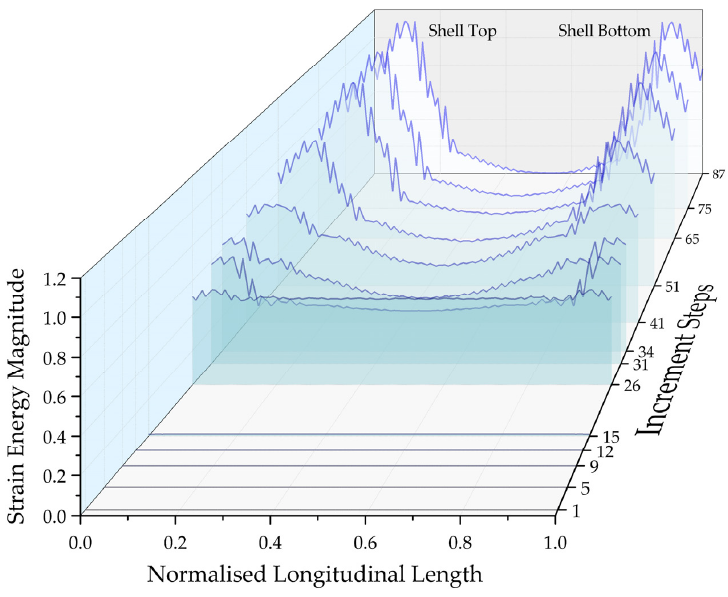
Figure 20. Shell (9 m at 24 mm) strain energy magnitudes along the normalised longitudinal length at typical increment steps, under the pure bending